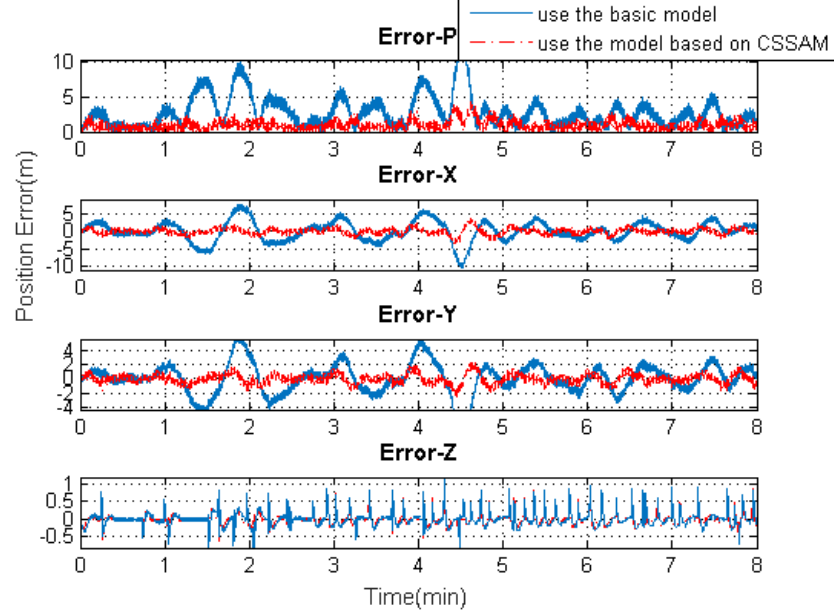
Figure 9. The 3D position solution accuracy comparisons using the basic model or the model based on the “current” statistical Singer acceleration model (CSSAM).